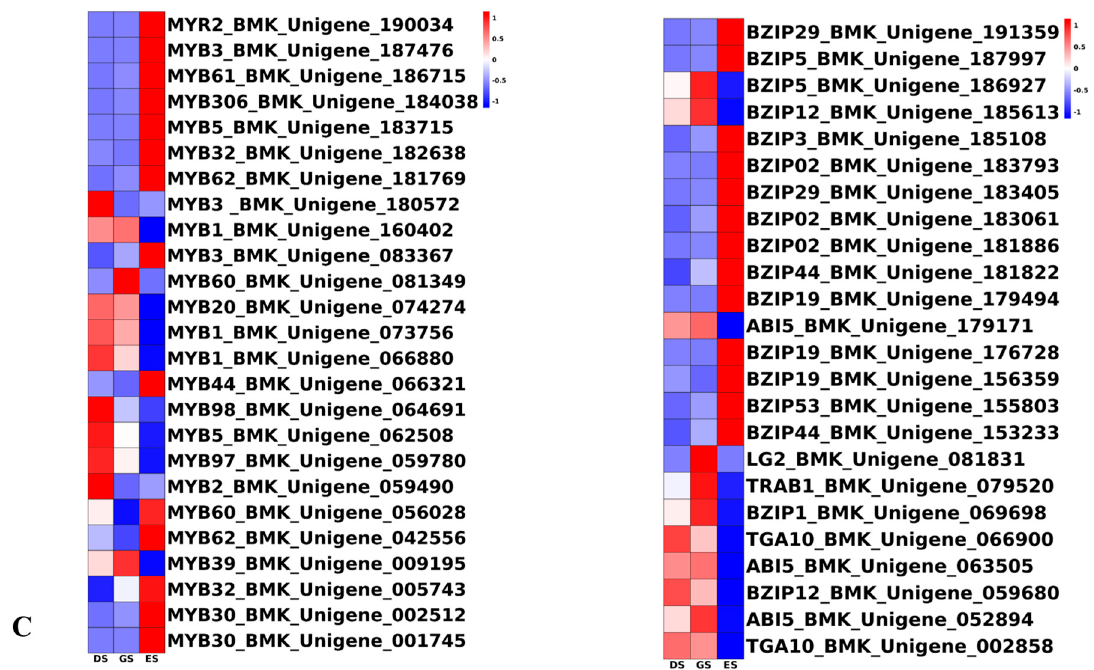
Figure 8. Number of differentially expressed transcription factors during seed germination in P. cyrtonema. ( A ) Top TF families according to gene number. ( B ) DEGs heatmap of ERFs, WRKYs, and BHLHs. ( C ) DEGs heatmap of MYBs and BZIPs during different germination phases in P. cyrtonema seeds.